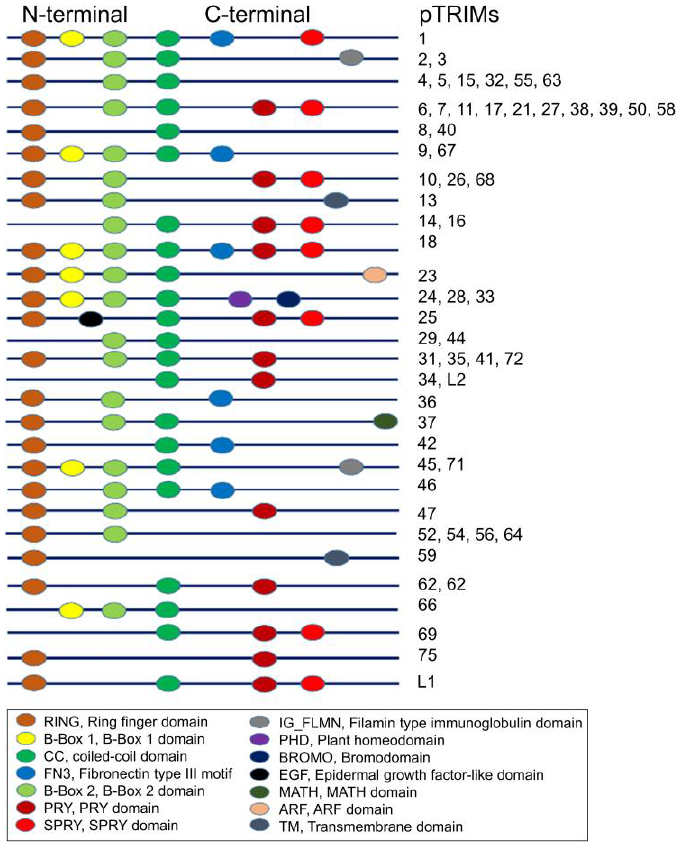
Figure 1. Predicated structures of porcine TRIMs. Sixty-one sequences of porcine TRIMs were ana- lyzed, and the possible domains were predicated. The N-terminal of porcine TRIMs is conservative. In contrast, the C-terminal has a variety of variable domains. pTRIM, porcine TRIM.